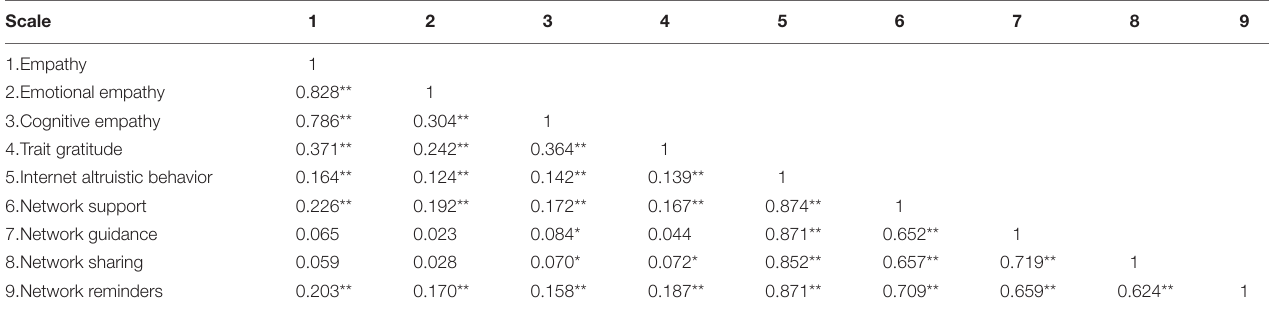
TABLE 3 | Correlations among scales of the BES, GQ-6, and the IABQ ( N = 805). Scale 1 2 3